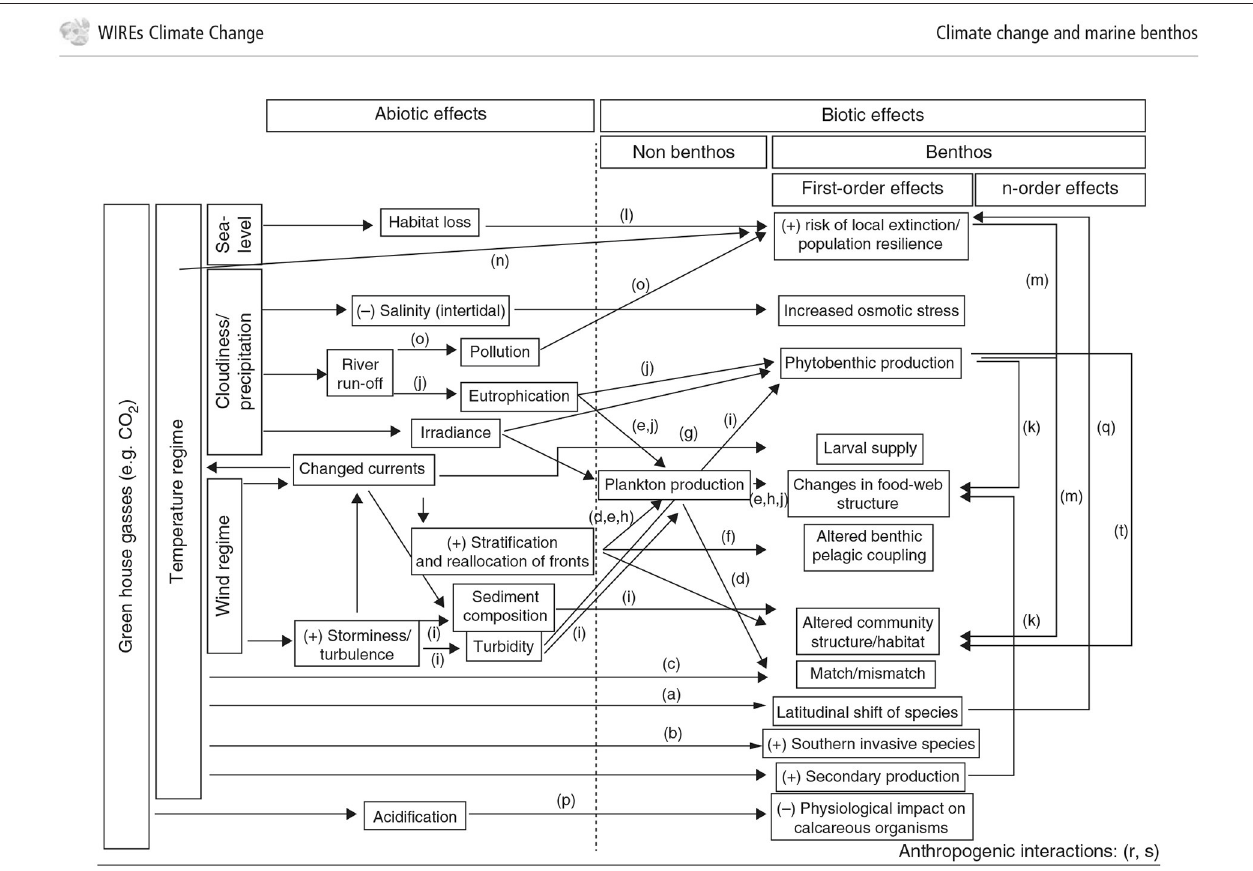
FIGURE 4 | Conceptual diagram of the effects of climate change on benthic interactions. Illustration of the influence of increased CO 2 and temperature and the effects of biotic and abiotic components (Figure from: Birchenough et al. (2015)).